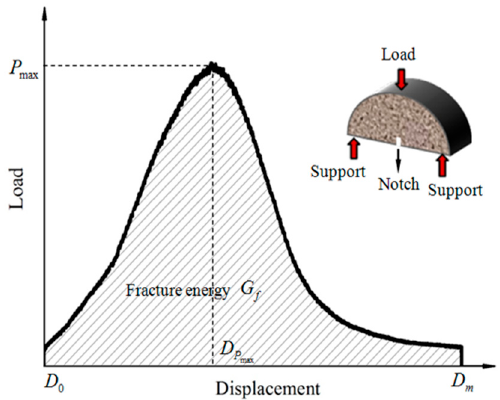
Figure 5. Load-displacement curve and test setup of SCB tests.